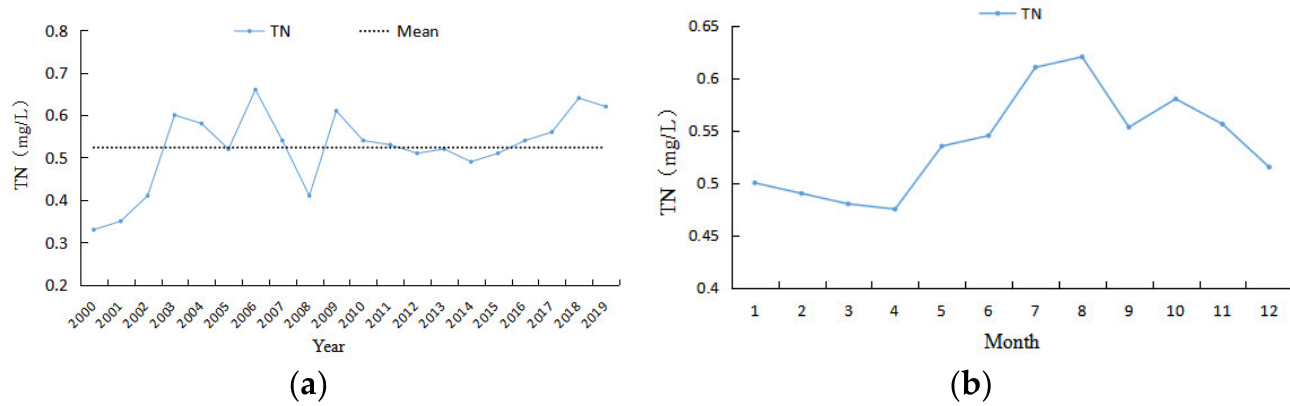
Figure 4. ( a ) Annual and ( b ) monthly TN concentration in Erhai Lake, from 2000 to 2019. Figure 4b shows the monthly variation trend of the TN concentration in Erhai Lake from 2000 to 2019. The figure shows that the TN concentration was highest in August (0.620 mg/L) and lowest in April (0.475 mg/L). The TN concentration showed an upward trend from May to August and a downward trend from September to April. The TN concentration was highest in